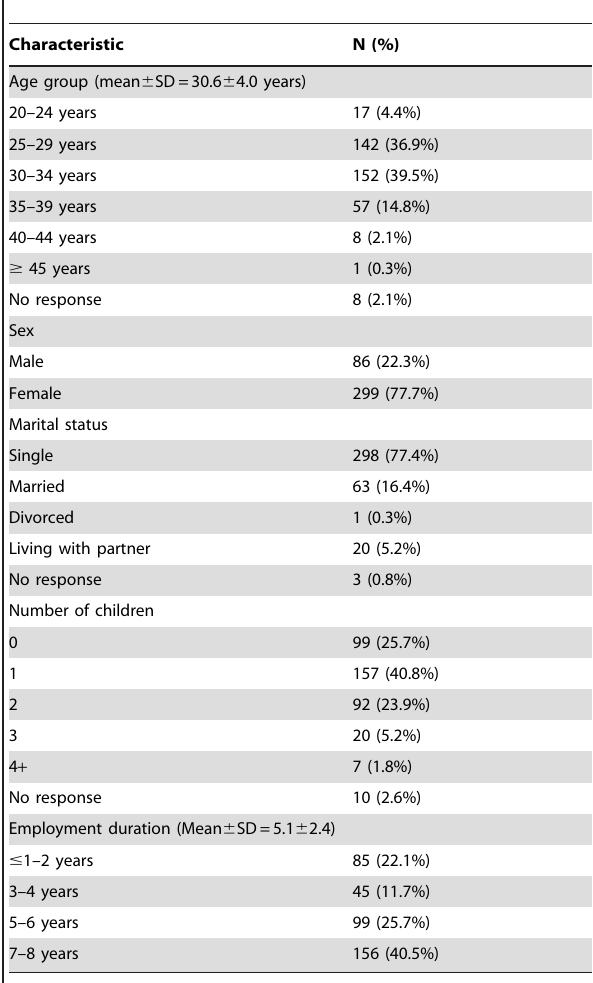
Table 2. Demographic characteristics of the Botswana lay counselor cadre